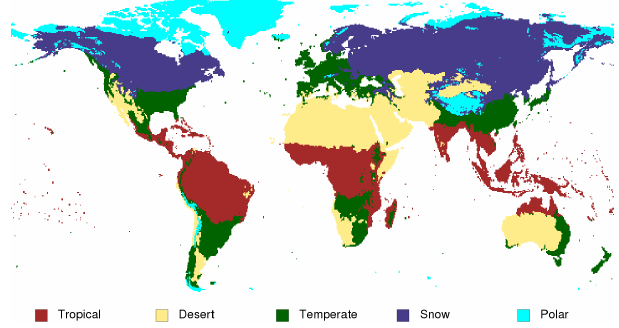
Figure 2. The Köppen–Geiger climate classification, based on the climatology of the WATCH Forcing Data